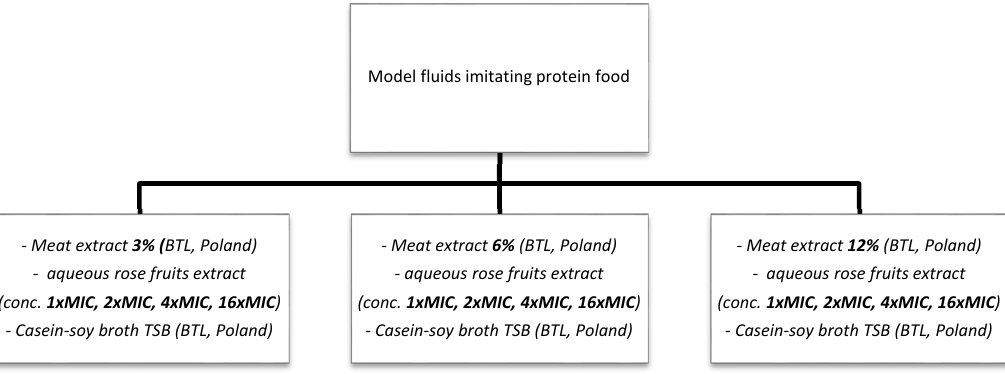
Figure A2. The scheme for preparing model fluids imitating protein food.